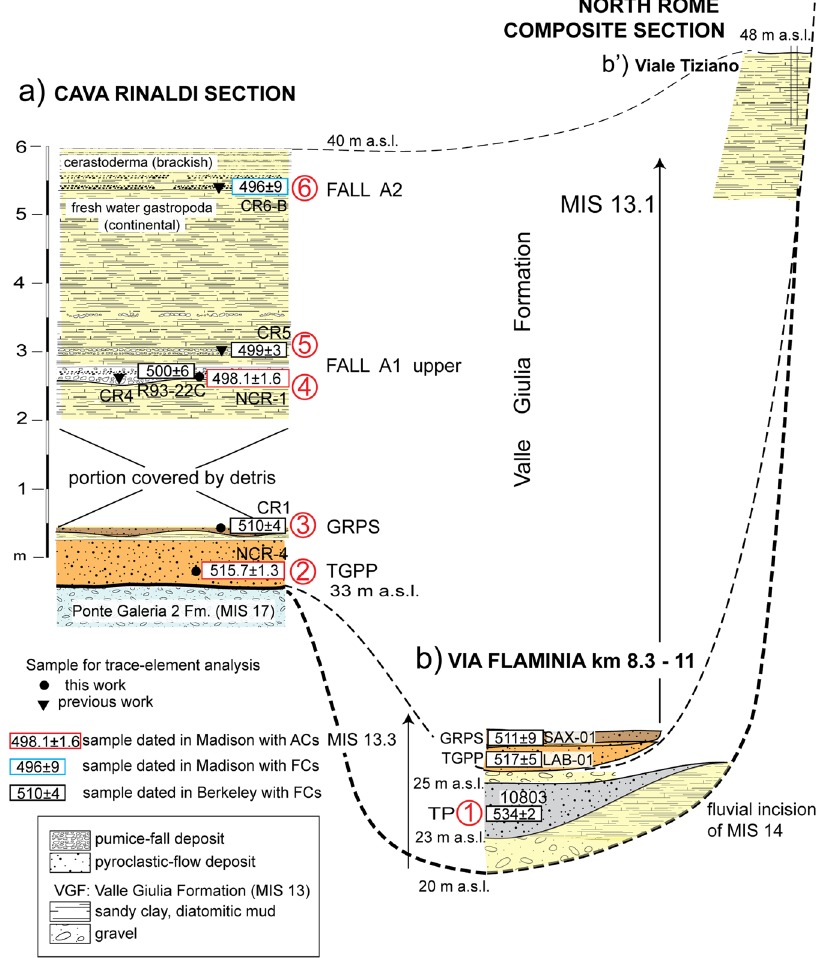
Figure 5. ( a ) Cava Rinaldi stratigraphy (modified and re-drawn here from previous stratigraphic scheme 16 ) and correlation with a composite section merging chronostratigraphic information fron northern Rome. ( b –b’). Positions of the six 40 Ar/ 39 Ar dated samples used in this work to constrain aggradation of the VGF (red circles, 1–6), and of other dated samples (Table 1) are